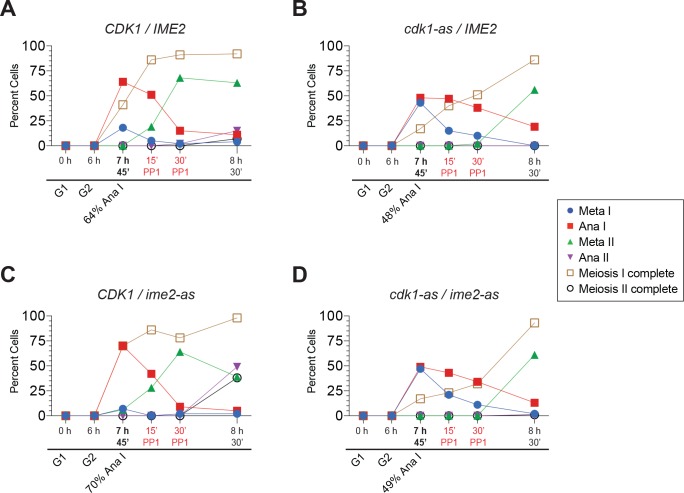
Cells in Figure 5 entered the MI-MII transition at the time of kinase inhibition.(A–D) Cell–cycle stage quantification for Figure 5A–5D, respectively. At the time of treatment with 10 µM 1–NM–PP1 and 20 µM 1–NA–PP1, all strains had ~50% of cells in Anaphase I. The 8 hr 30’ immunofluorescence time point is from cells in this same experiment that did not receive the kinase-inhibitor treatment, 45 min after the other cells did receive the inhibitor treatment. The purpose of this time point is to demonstrate that all four strains would successfully complete meiosis I had they not been received any kinase inhibitor.